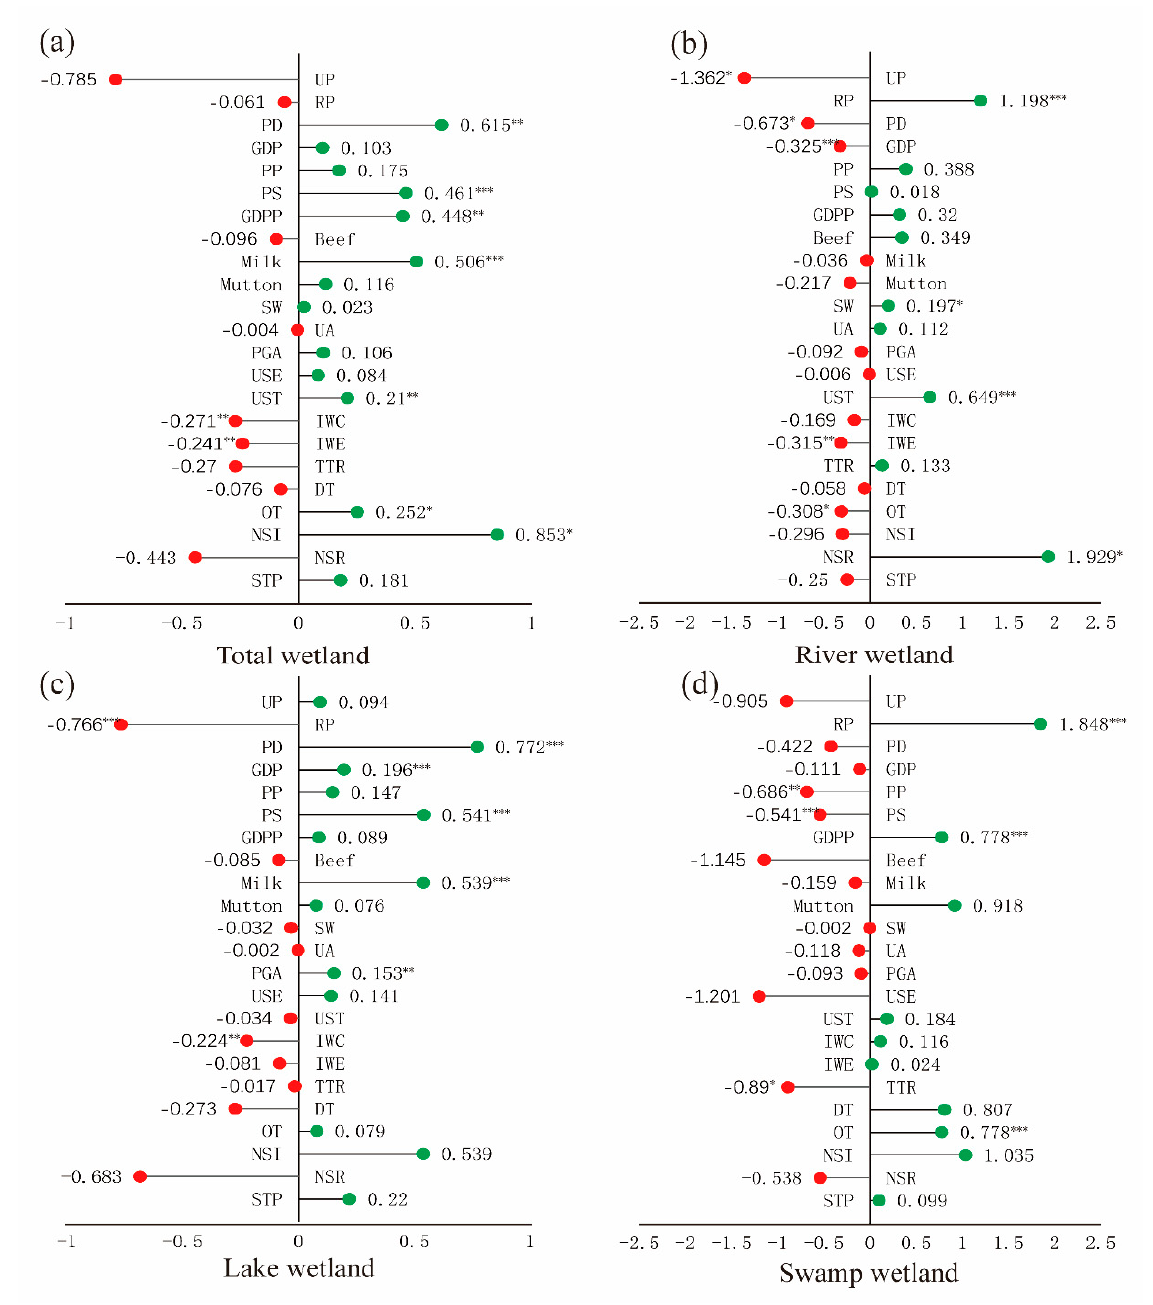
Figure 4. Standard coefficients between the ( a ) total wetland, ( b ) river wetland, ( c ) lake wetland, and ( d ) swamp wetland areas and socio-economic driving forces. Red dots represent negative correlation and green dots represent positive correlation. *, **, *** represent significance less than 0.05, 0.01 and 0.001. UP, Urban population; RP, rural population; PD, population density; GDP, gross domestic product; PP, percentage of primary industry; PS, percentage of secondary industry; GDPP, GDP per person; SW, sheep wool; UA, urban area; PGA, per capita green area; USE, urban sewage emission; UST, urban sewage treatment; IWC, industrial water consumption; IWE, industrial waste water emission; TTR, total tourism revenue; DT, domestic tourists; OT, overseas tourists; NSI, natural science research institutions; NSR, natural science researchers; STP, scientific and technical